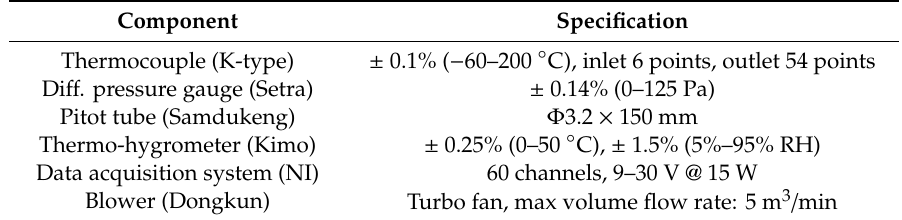
Figure 3. Photo and schematic diagram of the PTC heater experimental apparatus. Table 2. Specification of PTC heater experimental